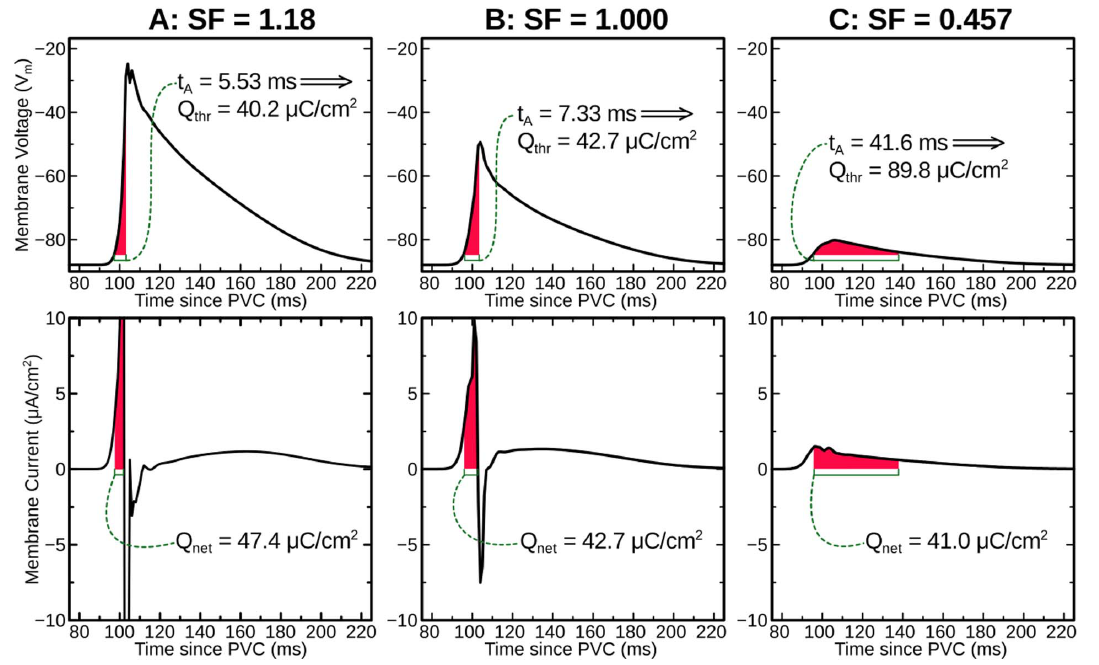
Figure 1. Graphical illustration of SF calculation from V m and I m traces in a model with 50% I Na and arrested sinus rhythm. 3 cases are shown: just above threshold (A), at threshold (B), and well-below threshold (C). For a particular excitation interval t A , the charge necessary to initiate an AP is estimated based on behavior in uncoupled cells. Notably, for the example shown in (C), I m never crosses below 0. SF: safety factor; V m : transmembrane voltage; I m : transmembrane current; I Na : sodium current; AP: action potential; Q net : charge available to depolarize the membrane (incoming minus